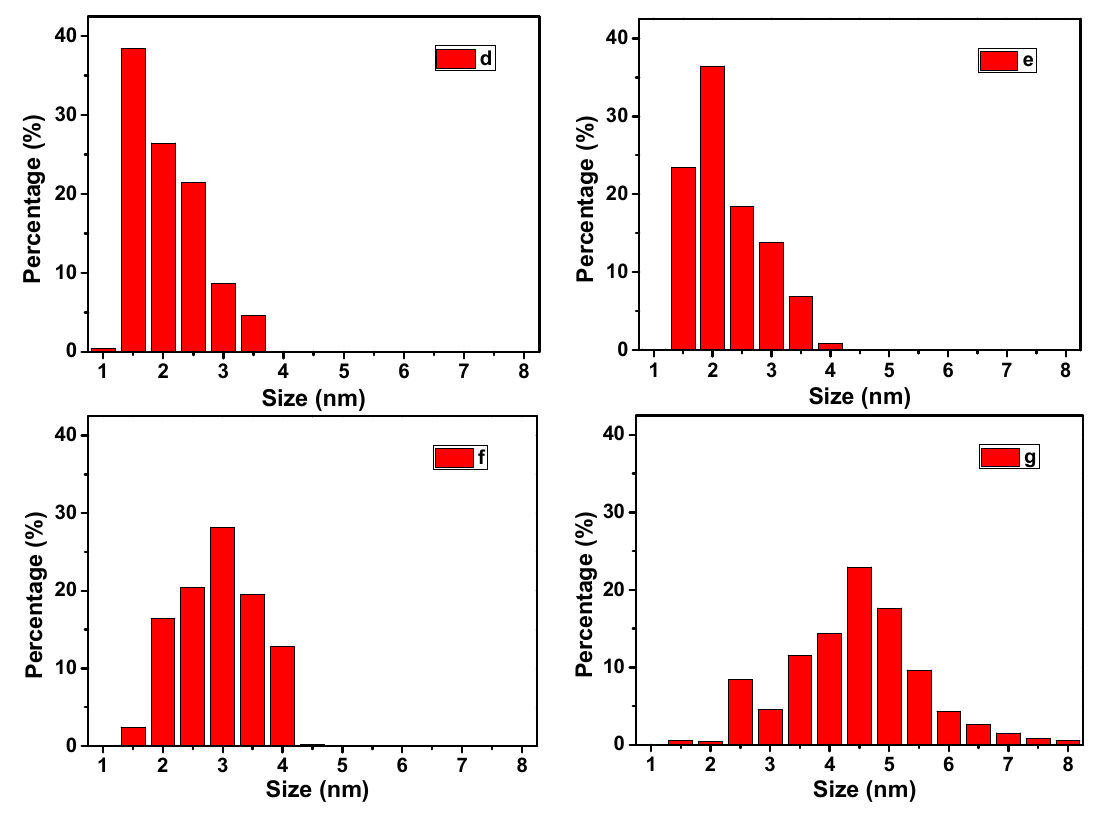
Figure 2. Size distributions of metal oxide particles for ( d ) CuCe 0.25 Zr 0.75 /ZSM-5, ( e ) CuCe 0.5 Zr 0.5 /ZSM5, ( f ) CuCe 0.75 Zr 0.25 /ZSM-5, and ( g ) CuCe 1 /ZSM-5.